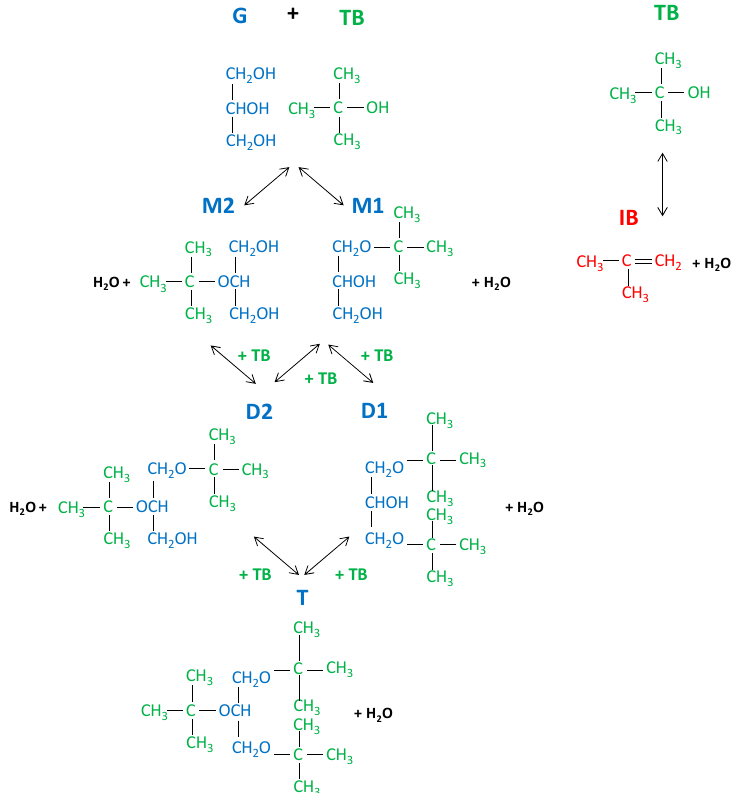
Figure 1. Reaction scheme of glycerol (G) etherification with tert -butyl alcohol (TB) and secondary reaction to isobutene (IB) from TB dehydration. Adapted from Pico et al., 2012 [9].